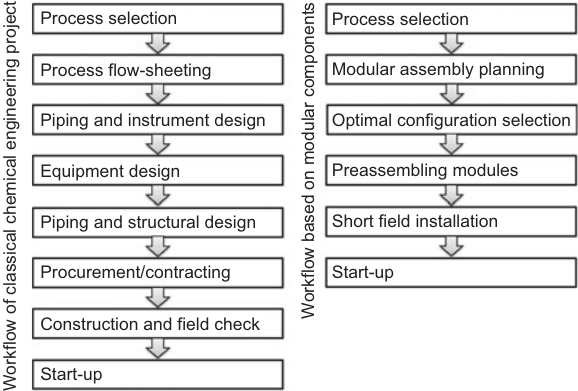
Figure 1 Project workflow – Classical workflow vs. workflow based on modular components. It is assumed that the modular components are “off-the-shelf” or benefit from serial manufacture of the modular plant. Otherwise, there would also be work steps as process flow sheeting etc. similar to classical project